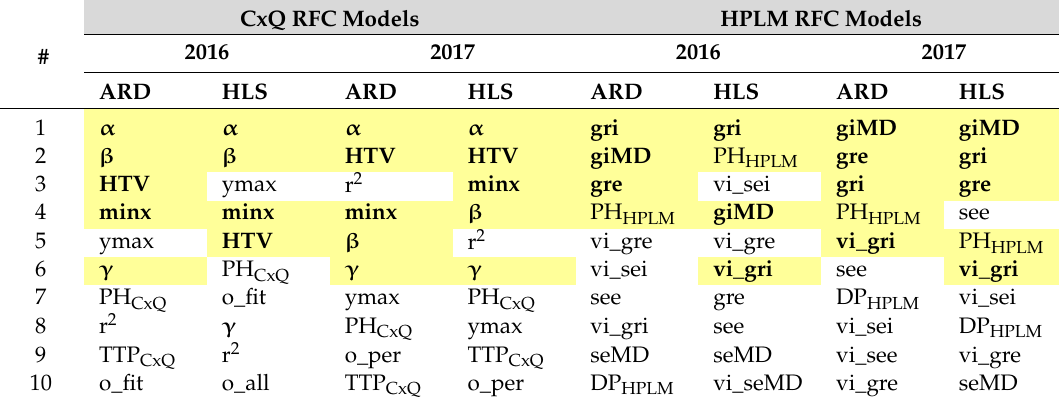
Table 9. Top 10 most important variables of CxQ and HPLM RFC models. Variables highlighted in light yellow are those that consistently appear in the top 6 most important variables (at least three times over four-year data combinations). Bolded items are variables related to the initial green-up phase of the seasonal